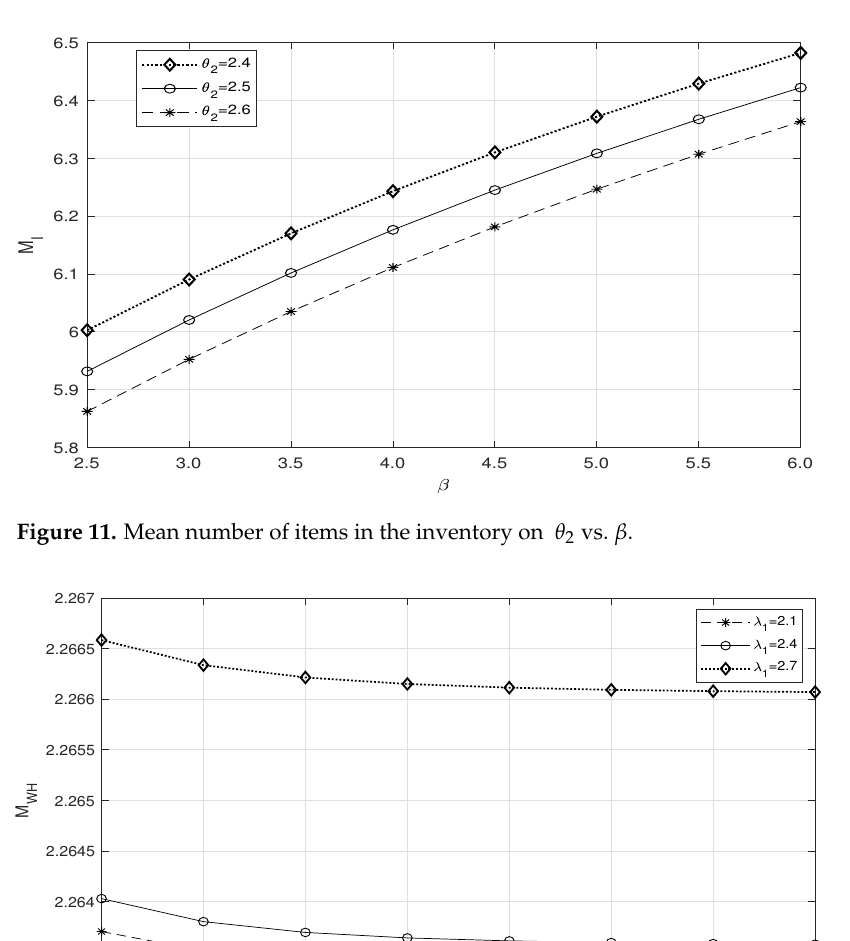
Figure 10. Mean number of items in the inventory on θ 1 vs. γ .